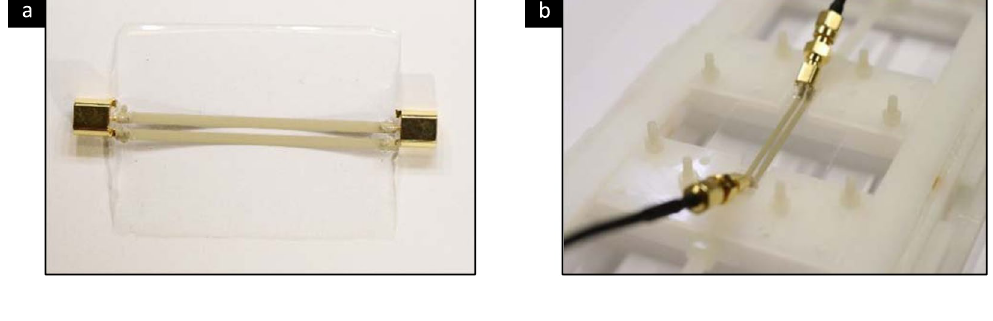
4 SCiEnTiFiC REPORTS | 7: 10958 | DOI:10.1038/s41598-017-11392-w